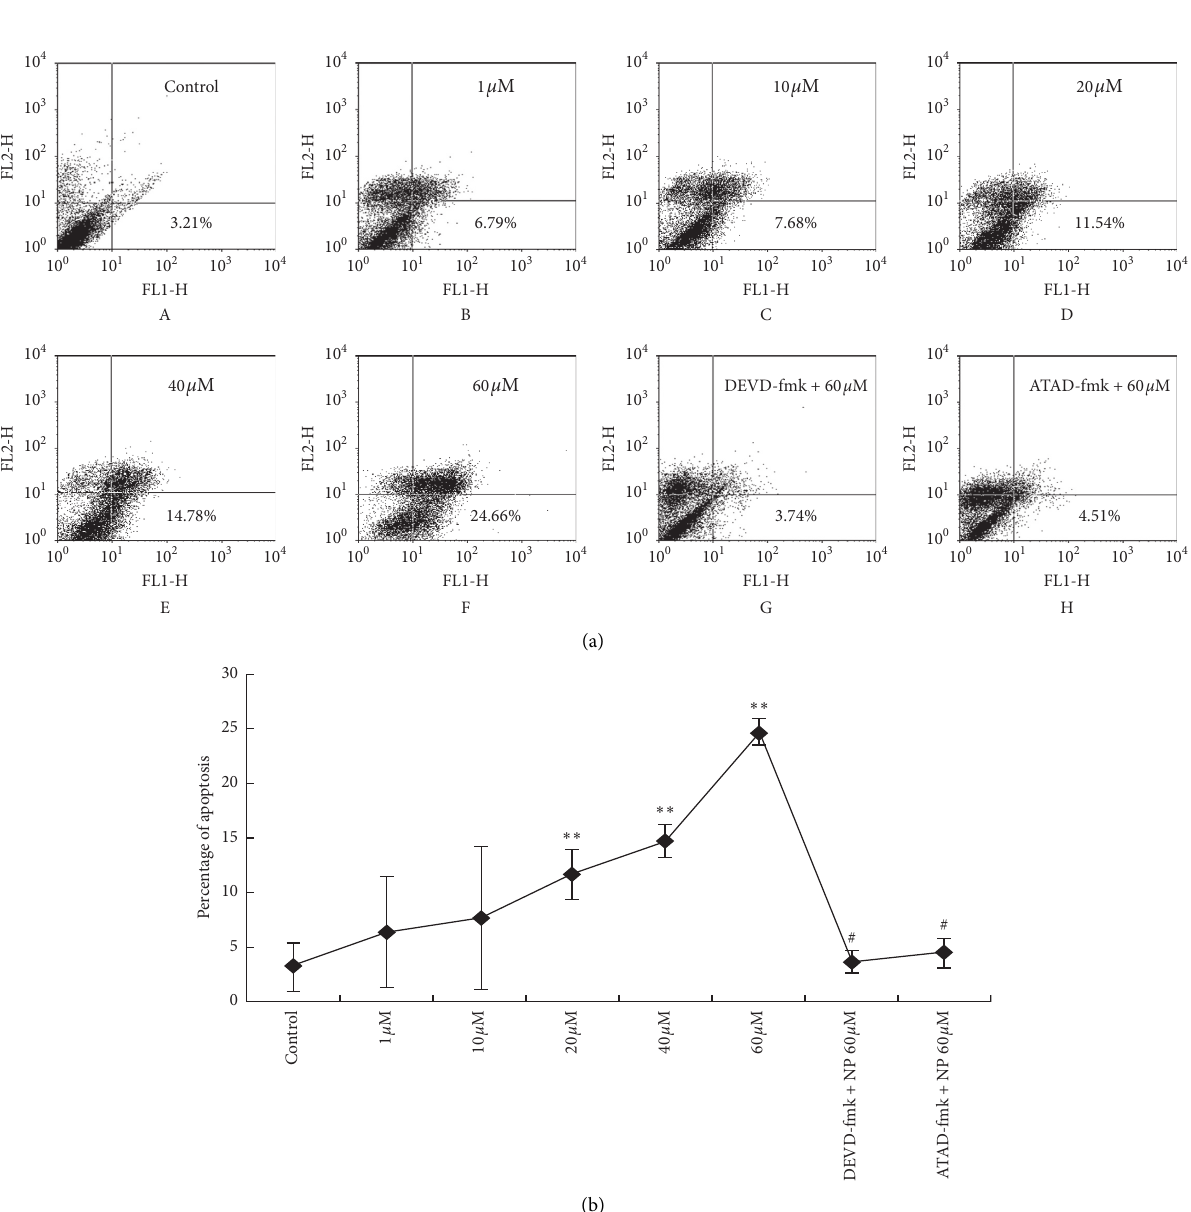
Figure 3: NP induced apoptosis in NCTC Clone 1469cells. After exposure to NP for 12h, NCTC Clone 1469 were collected for Annexin V–FITC and PI staining followed by flow cytometry analysis. (a) Flow cytometric plots. (b) Flow cytometric analysis result. Results are presented as mean ± SD with triplicate measurement. ∗∗ P < 0 . 01 versus the control group; # P < 0 . 05 versus 60 μ M NP